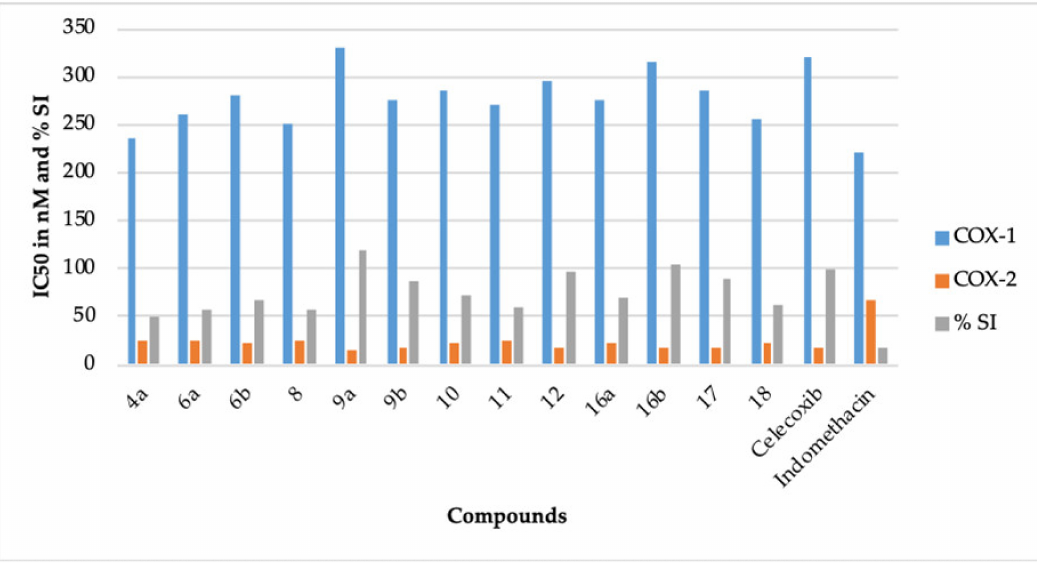
Figure 1. The IC 50 (nM) and the % selectivity index (SI) of compounds 4a , 6a , 6b , 8 , 9a , 9b , 10 , 11 , 12 , 16a , 16b , 17 , 18 , celecoxib, and